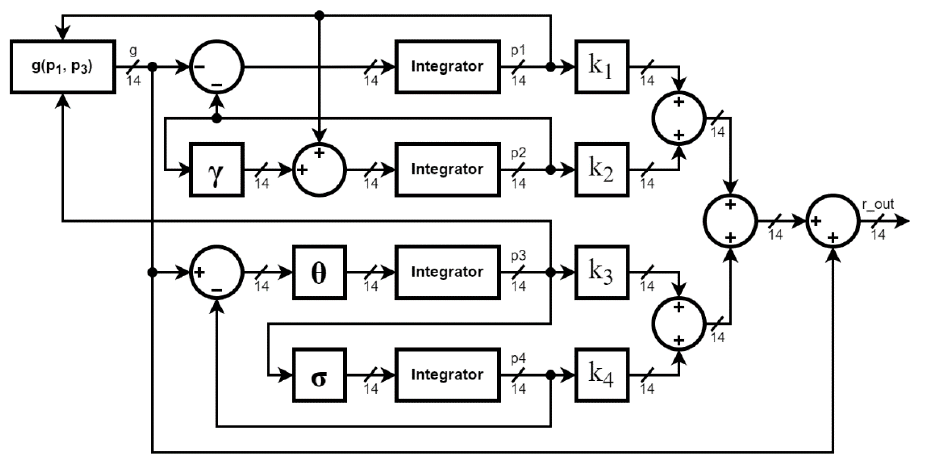
Figure 10. Structure of the master chaos